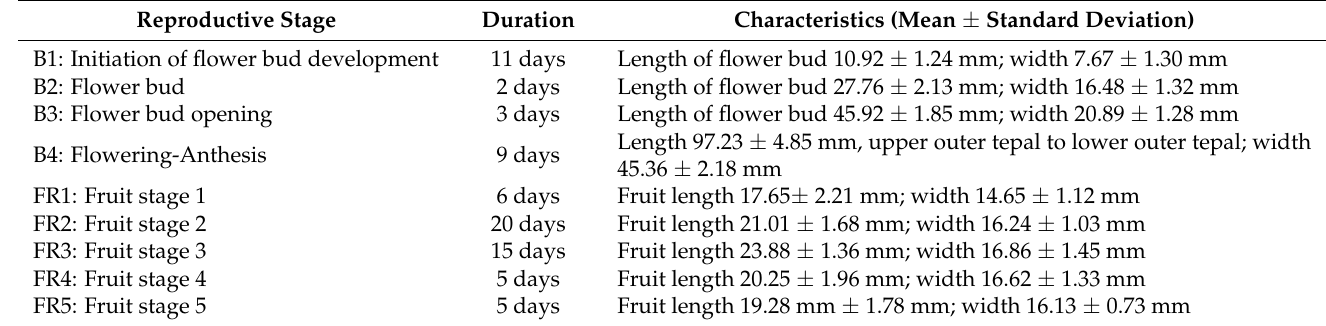
Table 1. Phenological evaluation chart of A. pelegrina reproductive